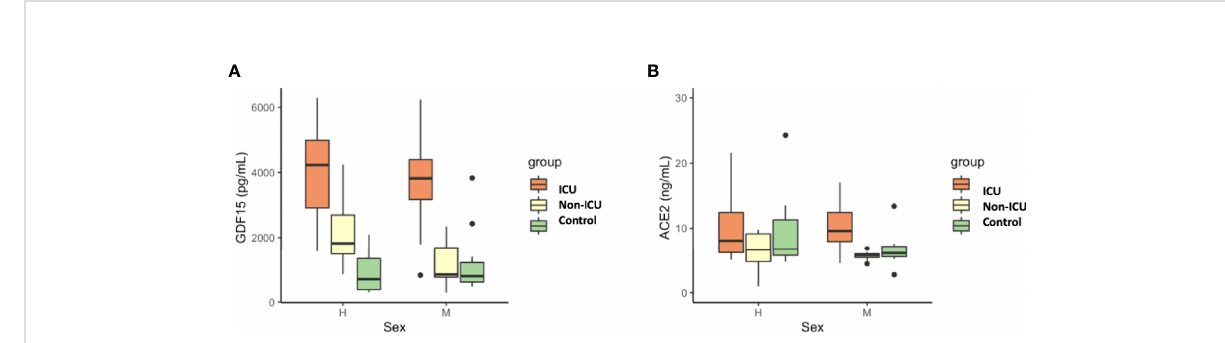
FIGURE 4 Differences in circulating GDF15 (A) and ACE2 levels (B) by sex in COVID-19 patients and the uninfected control group. No differences were found by sex in GDF15 and ACE levels. The box plots represent the maximum and minimum levels (whiskers), the upper and lower quartiles, and the median. The length of each box represents the interquartile range. Dots represent outliers. Statistical signi fi cance between groups was determined using the ANOVA